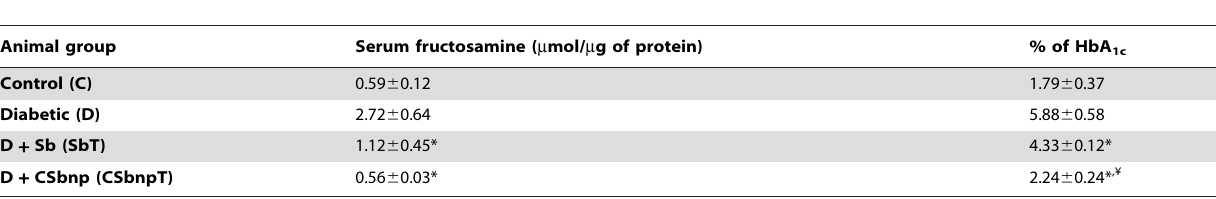
Table 4. Effect of Sb and CSbnp on glycohemoglobin (HbA 1c ) and fructosamine levels in diabetic rats.